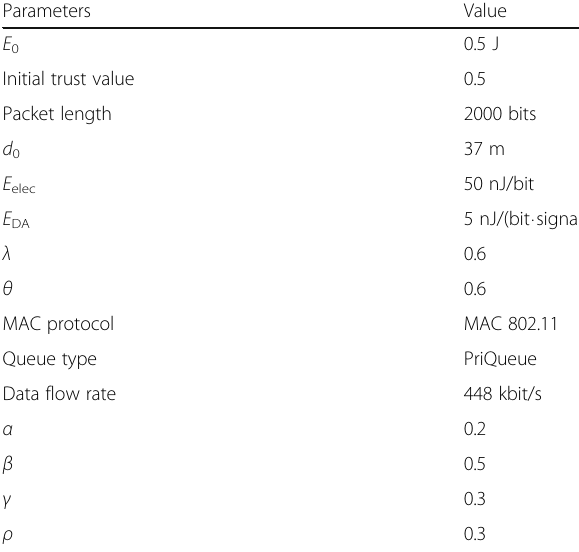
Table 1 The specific parameters